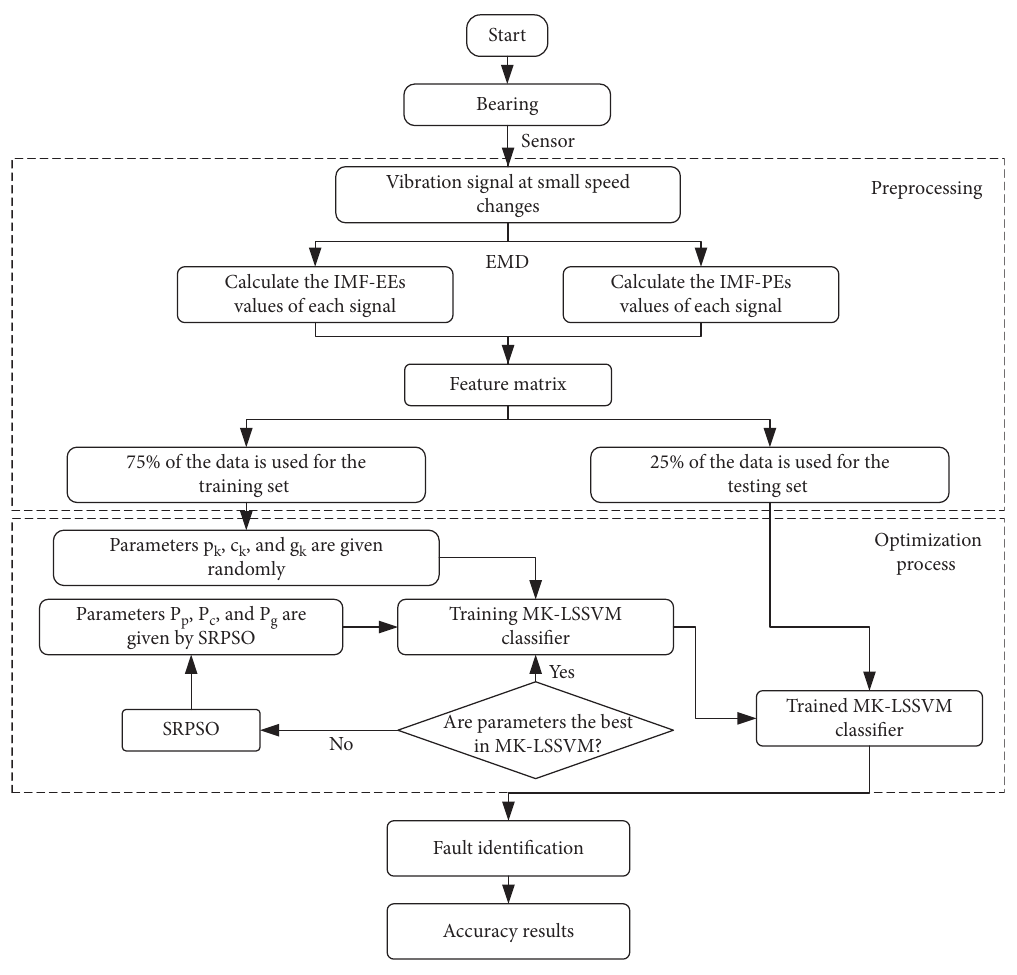
Figure 4: MKLS-SVM failure classification